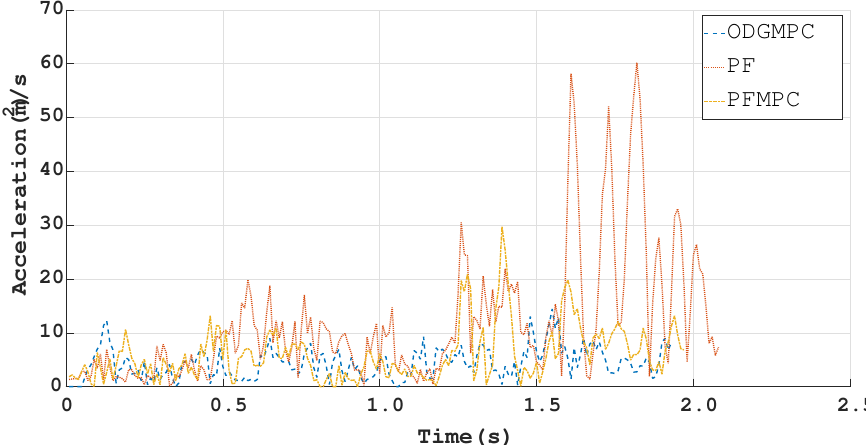
Figure 30. Results of the acceleration from Scenario 3 for one dynamic obstacle and one static